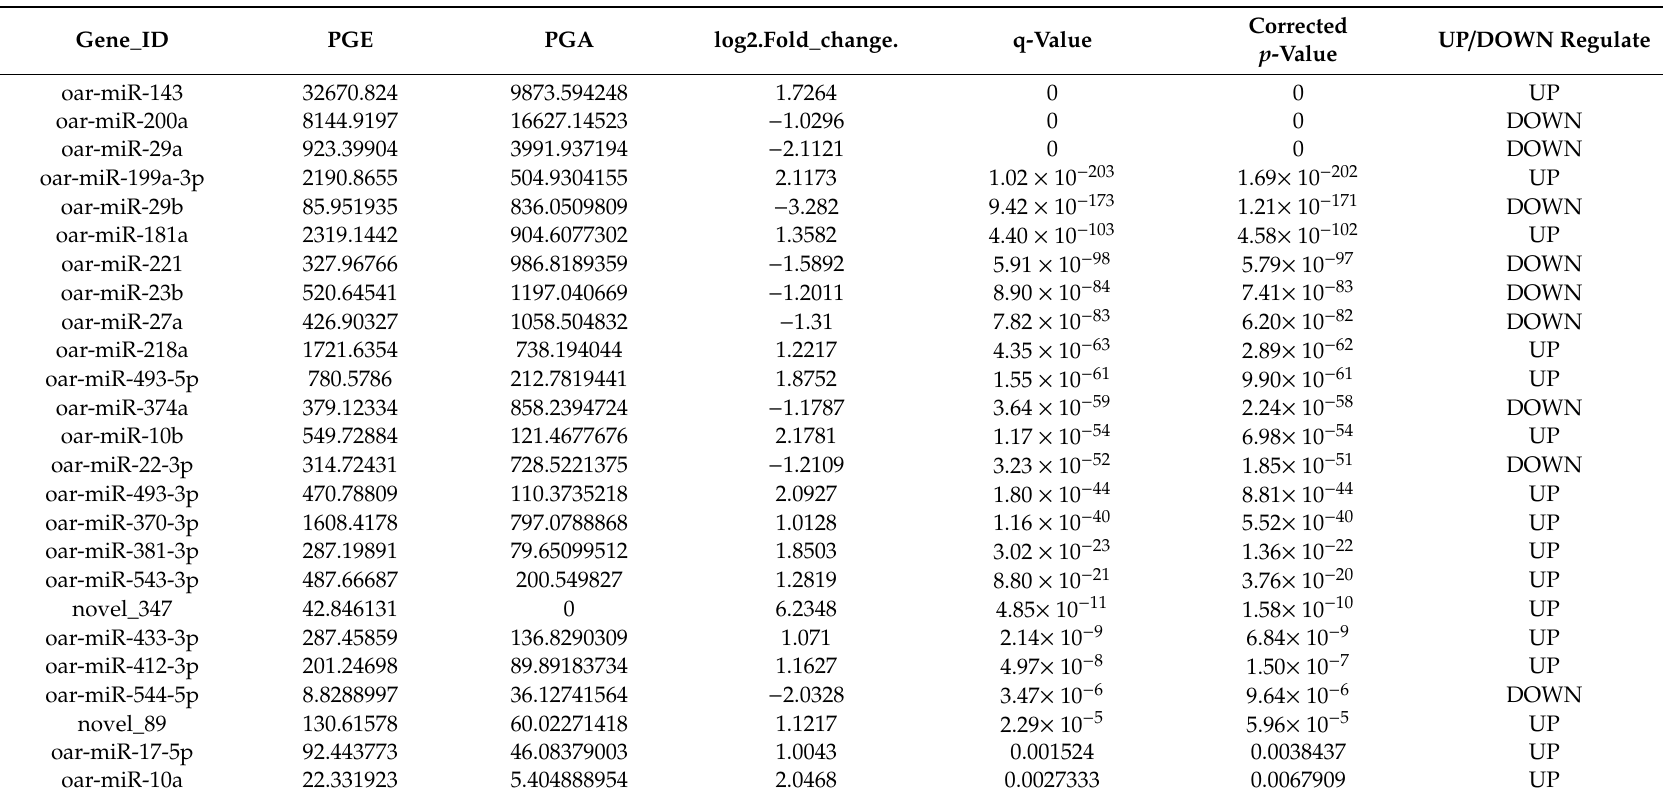
Table 1. Di ff erentially regulated miRNAs identified between PGE and